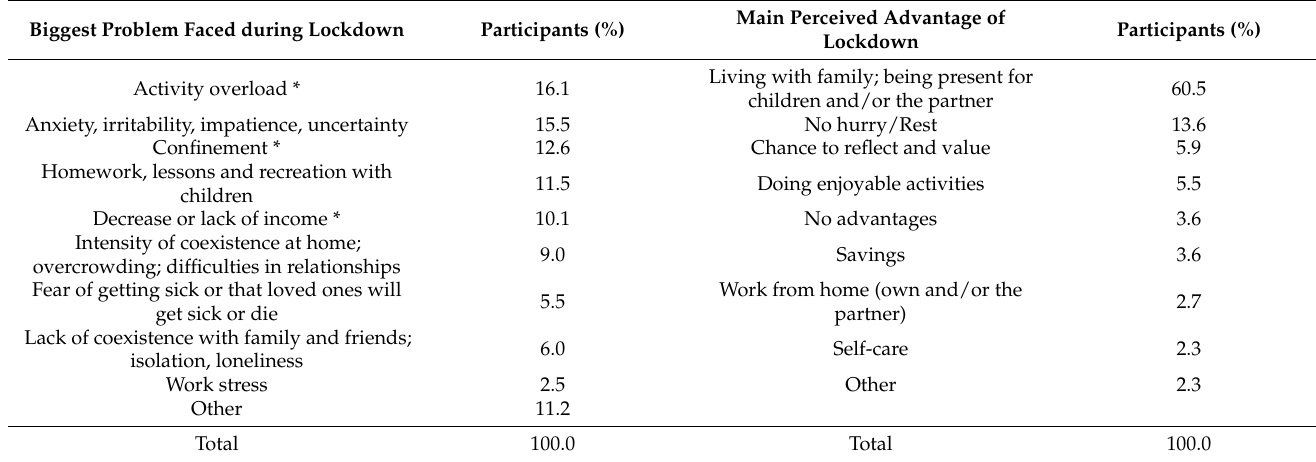
Table 3. Percentage distribution of the participants according to the biggest problem they said they faced during lockdown and the main perceived